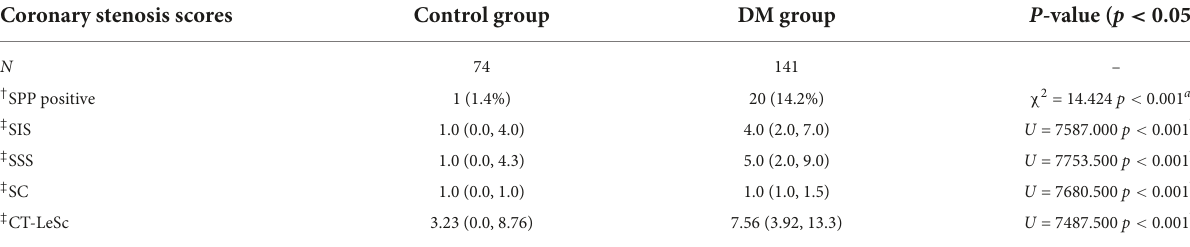
TABLE 6 Coronary stenosis scores of the study population. Coronary stenosis scores